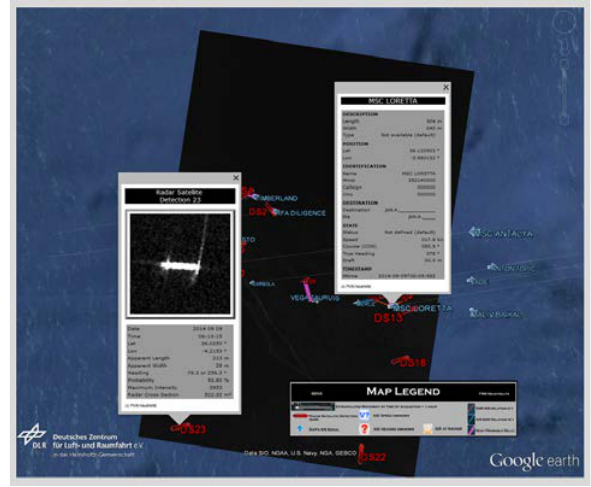
Figure 4. kmz output product extract; image data product TerraSAR-X merged with ground based AIS data;